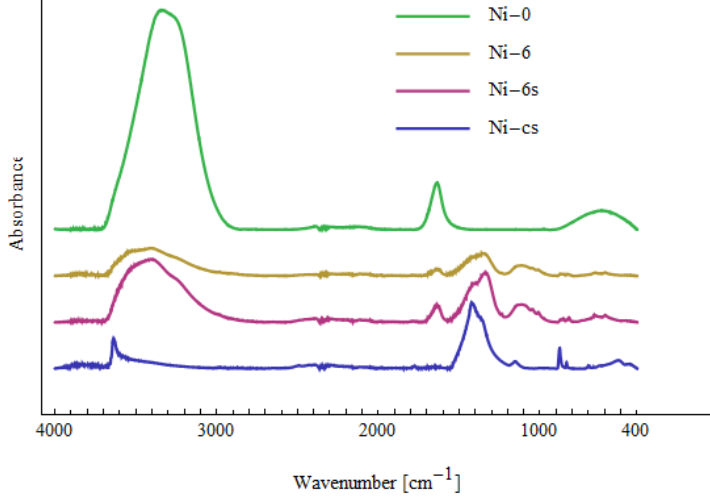
Figure 8. FTIR spectra related to solutions containing Ni(II).